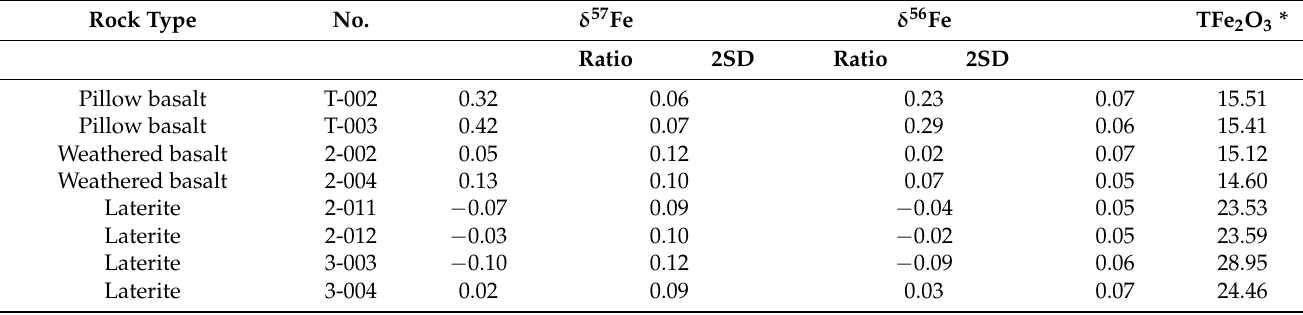
Table 1. Magnetite iron isotopic analytical results of the Shazi anatase deposit.